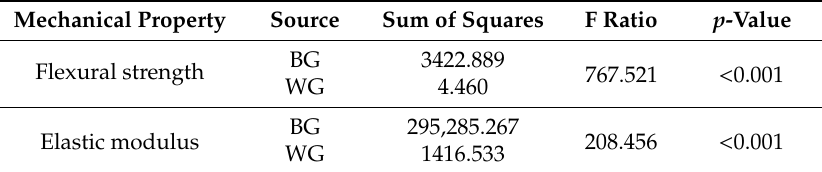
Table 4. ANOVA test for flexural strength and modulus.